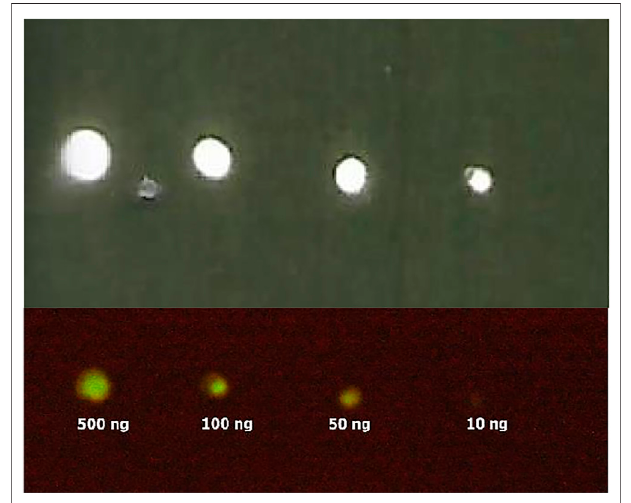
FIGURE 4 | Bioluminescence immunodot showing different amounts of immobilized Anti-SARS-CoV-2 nucleoprotein using ZZ-AmyLuc fusion protein: (upper image) CCD imaging, and (lower image) photographic detection. Using CCD imaging, it is possible to detect up to 1 ng of primary antibody, whereas using photographic detection it is possible to detect up to 10 ng.